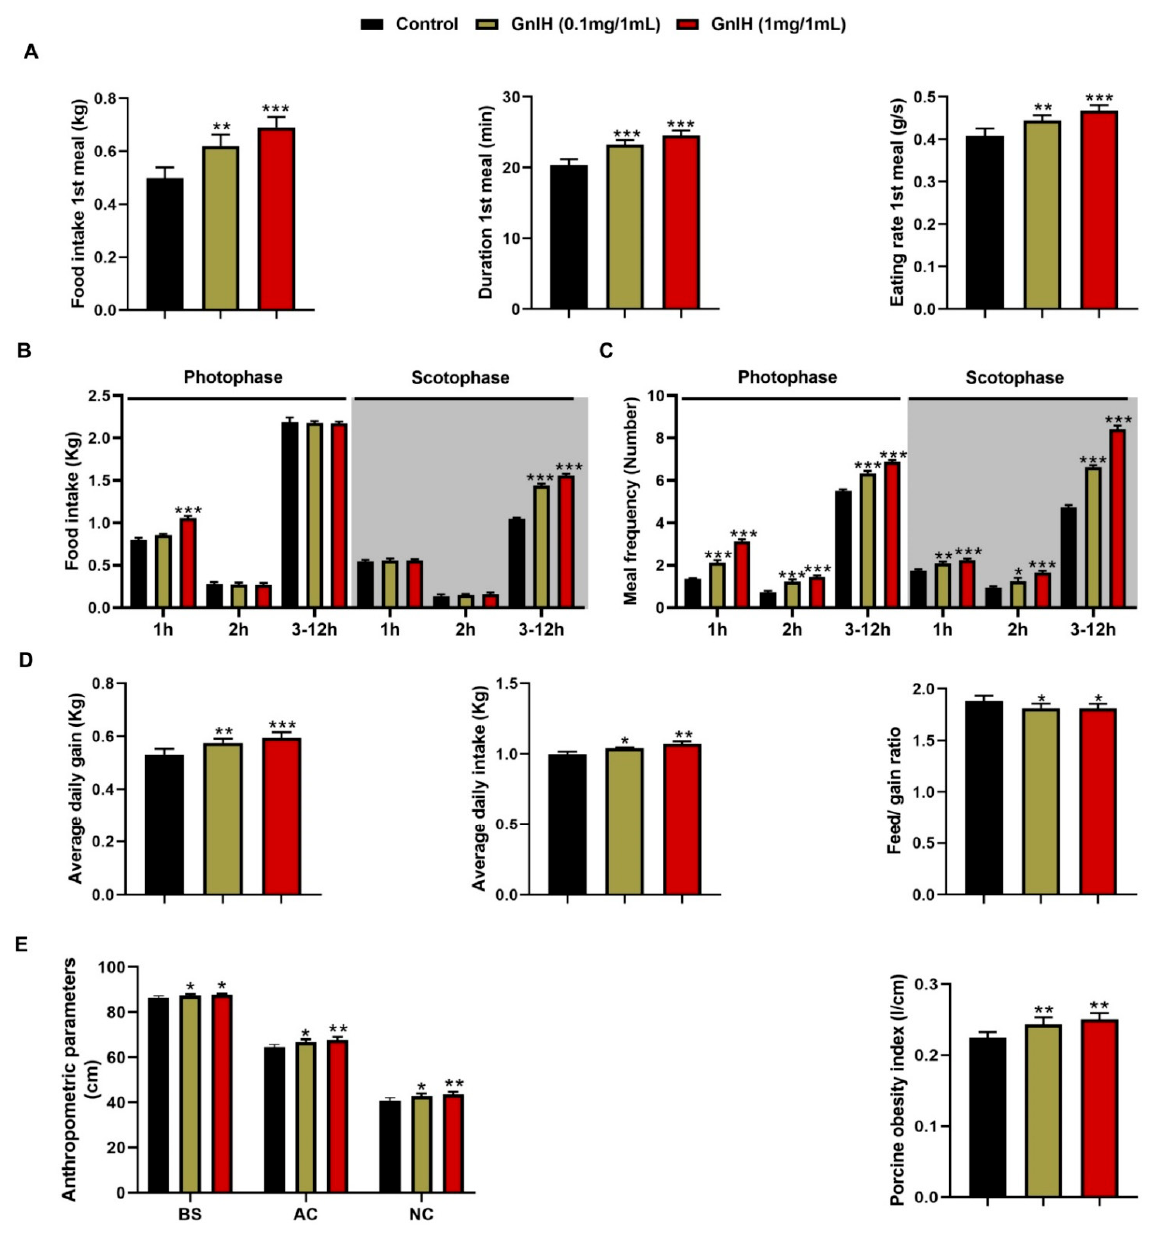
Figure 1. Intraperitoneally injected GnIH increases food intake, alters meal microstructure, decreases feed/gain ratio and increases body mass in piglets. ( A ) Effect of GnIH injected intraperitoneally on the structure of first meal in the fasting piglets. ( B , C ) The food intake ( B ) and meal frequency ( C ) were monitored over 14 days during different periods of the photophase and scotophase post- GnIH or vehicle injection in the ad libitum-fed piglets. ( D ) The average daily feed intake, average daily gain and feed/gain ratio of piglets intraperitoneally injected with different chronic doses of GnIH. ( E ) Anthropometric parameters and porcine obesity index of piglets intraperitoneally injected with different chronic doses of GnIH. BS, body size; AC, abdominal circumference; NC, neck circumference; POI, porcine obesity index. n = 5/group. The data are presented as the means ± SEM. * p < 0.05, ** p < 0.01 and *** p < 0.001 GnIH vs.